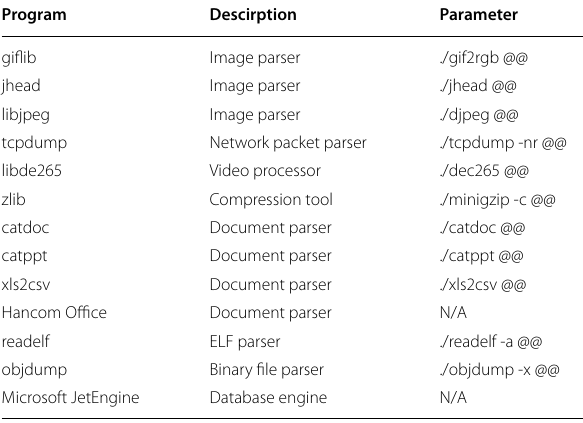
Table 1 Summary of 13 applications to